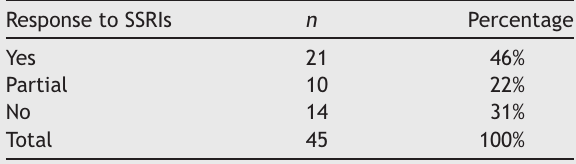
Response of patients with a diagnosis of chronic subjective dizziness pharmacologically treated with